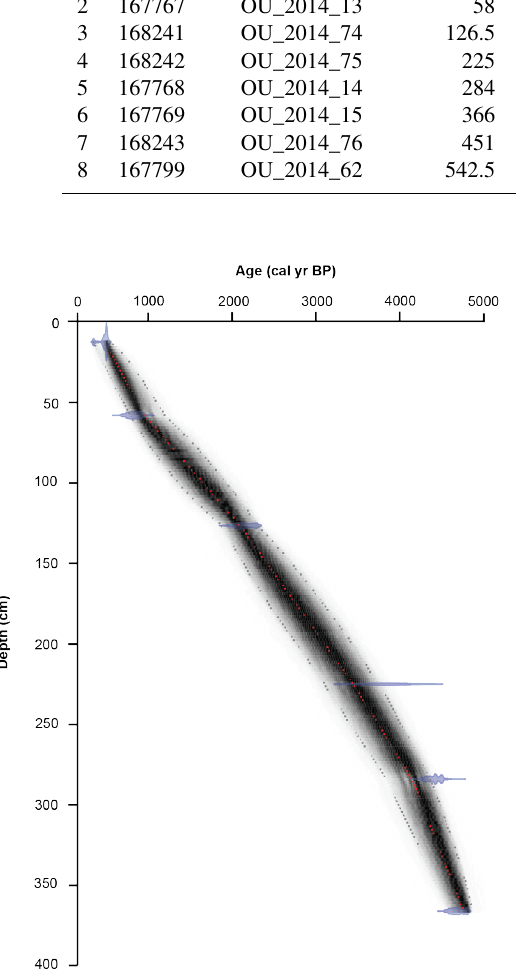
Figure 3. A posterior age–depth model for piston core 36P4 (grey field) calculated using Bayesian interpolation of six 14 C dates (from terrestrial organic macrofossil fragments) from core 36P4 from Hanfield Inlet. Age–depth model was constructed using Bacon soft- ware (Blauuw and Christen, 2011). See text for model input param- eters. Radiocarbon ages were calibrated to calyrBP using SHCal13 (Hogg et al., 2013). Red dots indicate the weighted mean calibration age and the grey dots represent the 95% confidence